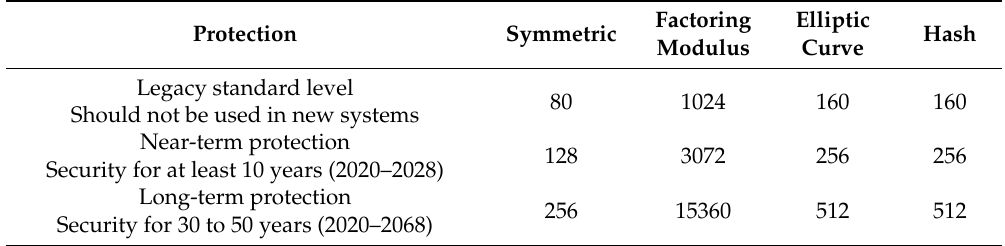
Table 1. The minimal key sizes for security (bits)